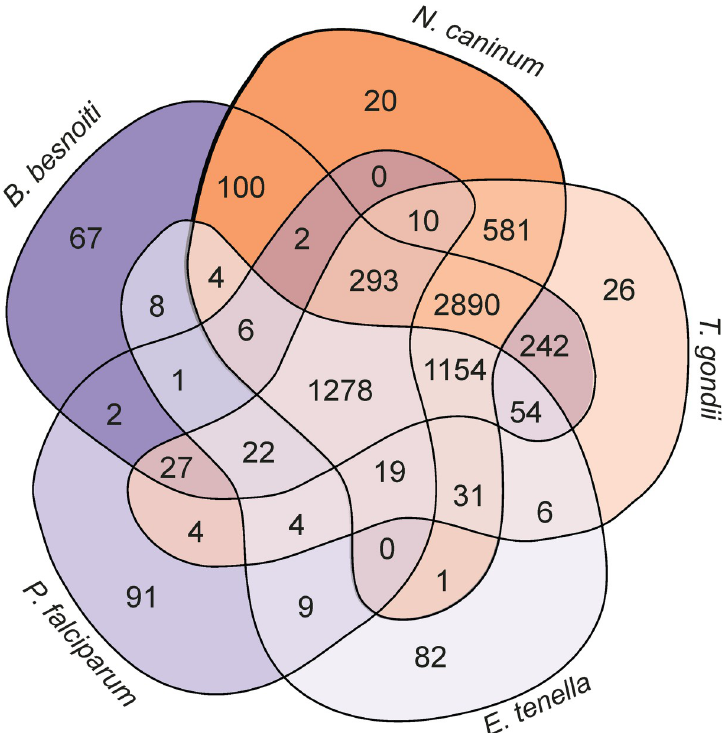
Fig 6. Orthology between species and unique B . besnoiti proteins. Venn diagram with orthologous groups in B . besnoiti and four other apicomplexan